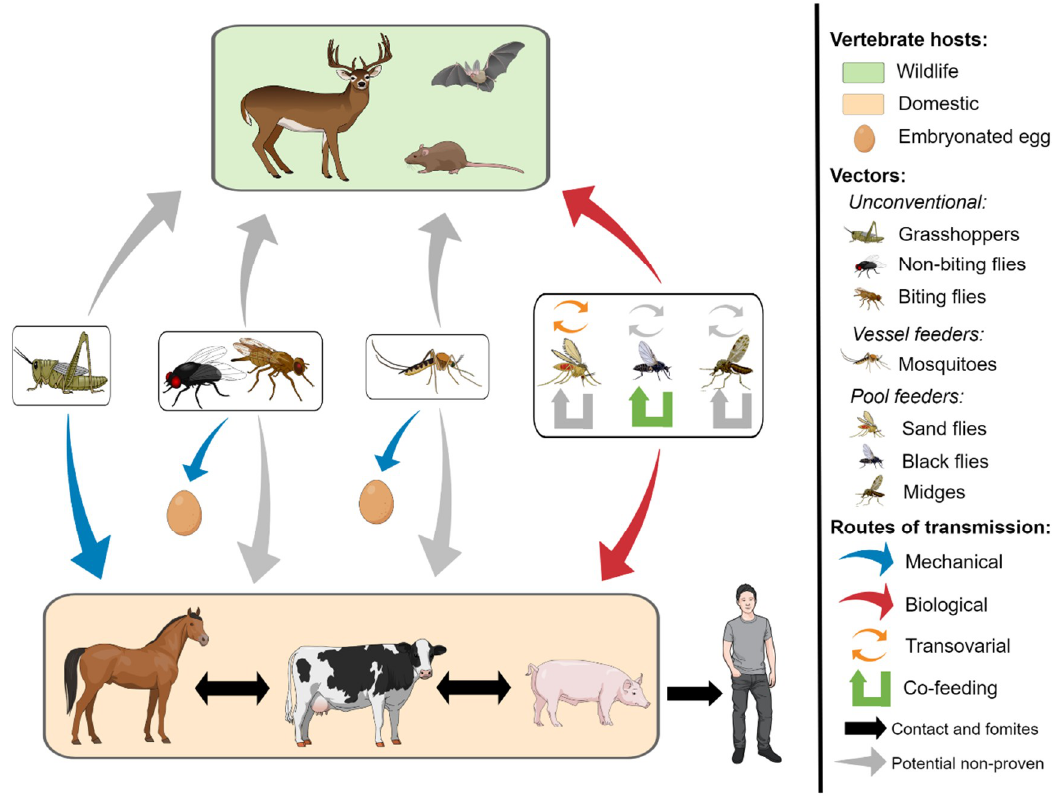
Figure 1. Transmission networks for vesicular stomatitis virus. The arrows represent viral flow between the vectors and hosts involved in known (colored) and proposed (gray) virus transmission cycles. Non-biting flies include houseflies, eye gnats, and anthomyiid flies. Biting flies include horseflies, deer flies, and stable flies. Biological transmission comprises a competent vector becoming infected with vesicular stomatitis virus (VSV) by feeding on blood or feeding on vesicular lesions, amplifying the virus, and transmitting it during subsequent blood-feeding. Mechanical transmission can occur through viral shedding from the alimentary canal, viral-contaminated mouthparts or feet, or by regurgitation of virus from gut contents. Experimentally biting flies and mosquitoes have been shown to transmit VSV to embryonated eggs. Non-conventional routes of transmission include transovarial transmission, co-feeding transmission, or by animals ingesting infected grasshoppers. As described in this review, the ecological characteristics of epizootic sites are key for virus transmission dynamics and some of the elements pictured may not always be present.